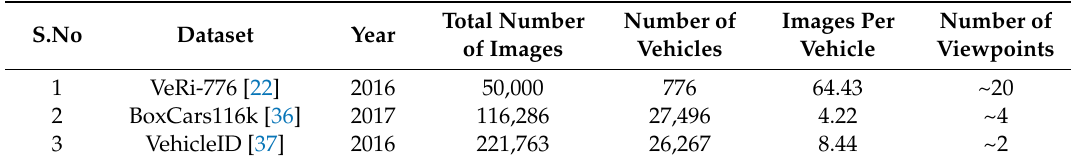
Table 1. Summary of publicly available